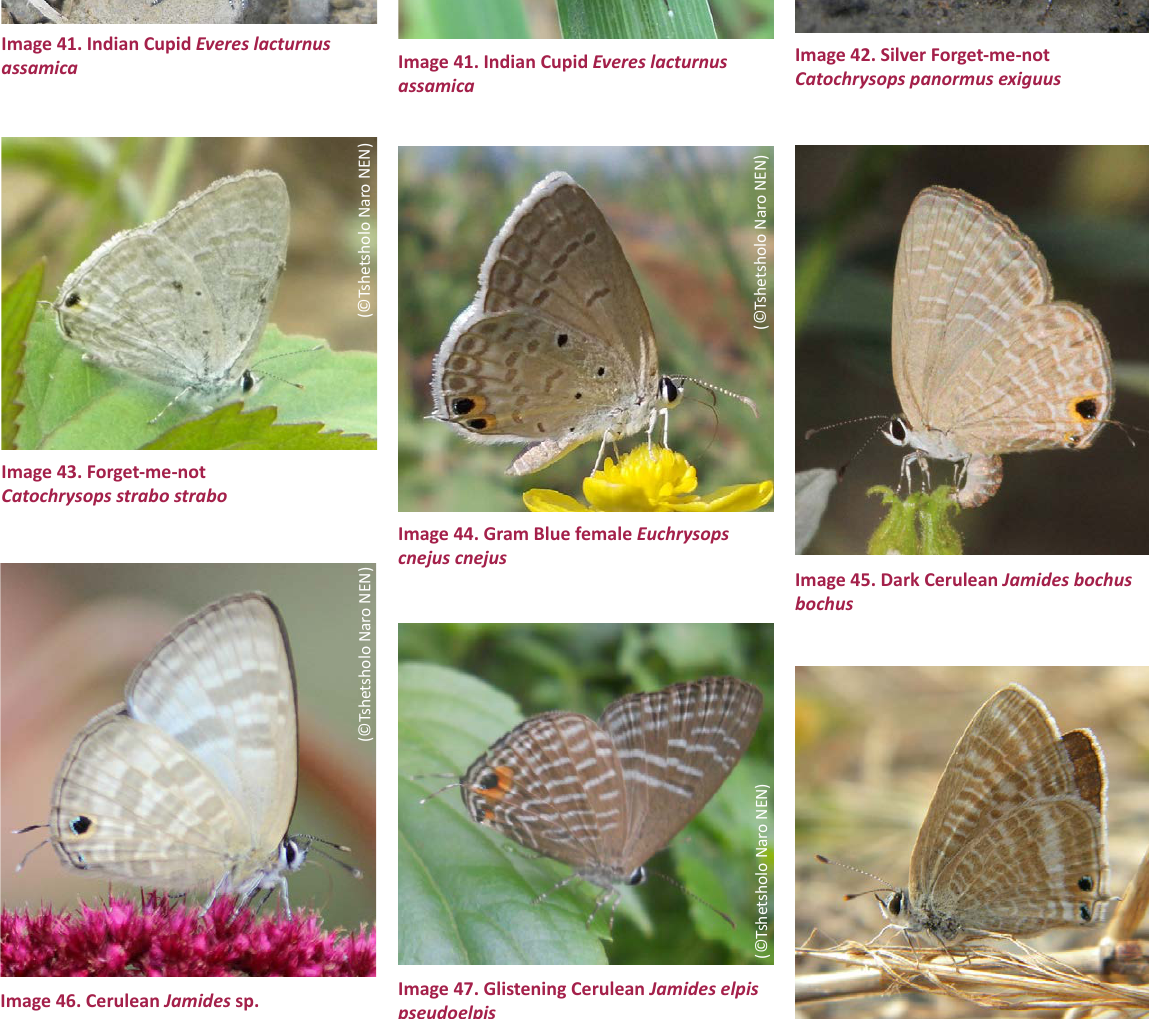
Image 48. Pea Blue Lampides